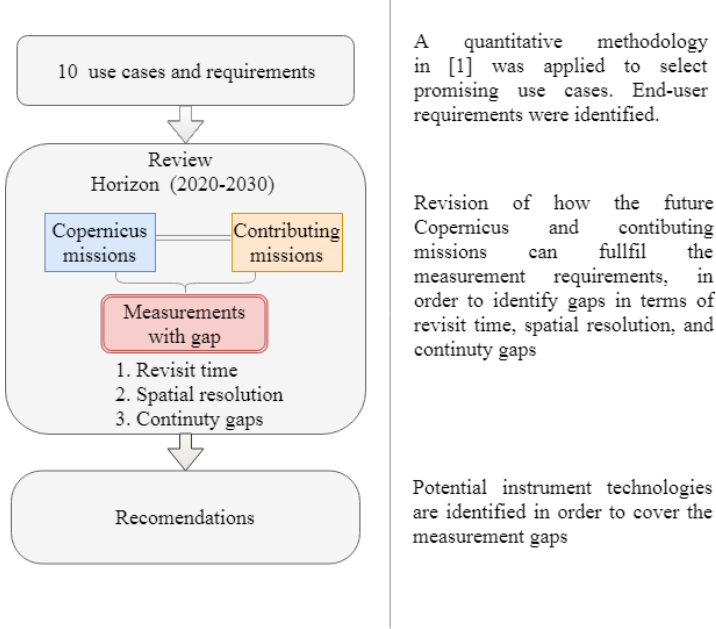
Figure 1. Methodology applied to define the end-user requirements and measurement